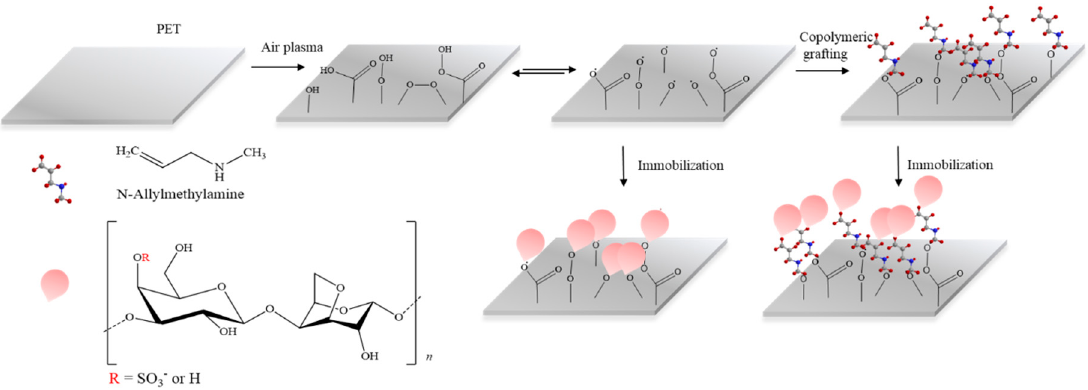
Figure 1. Schematic representation of plasma postirradiation grafting of N-allylmethylamine onto a PET surface followed by immobilization of FUR or κ -CA polysaccharide.